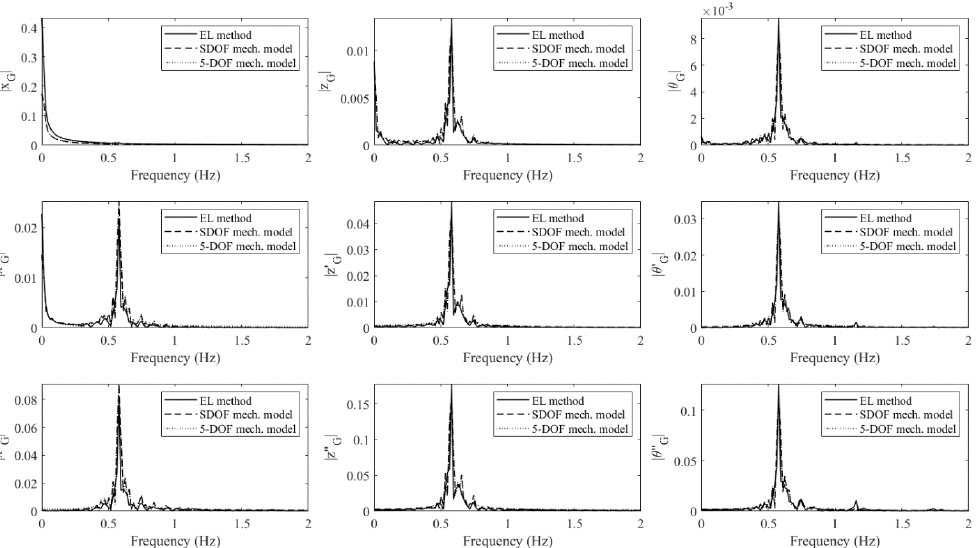
Figure 21. The response spectra of the floating body, configured with a water tank installed with porous media, undergoing small wave excitation. The free-surface elevations on the left-side (stern side) wall of the tank for the large- and small-wave cases are shown in Figure 22. Note that in the mechanical model, the free- surface elevation of the sloshing fluid can be obtained by: